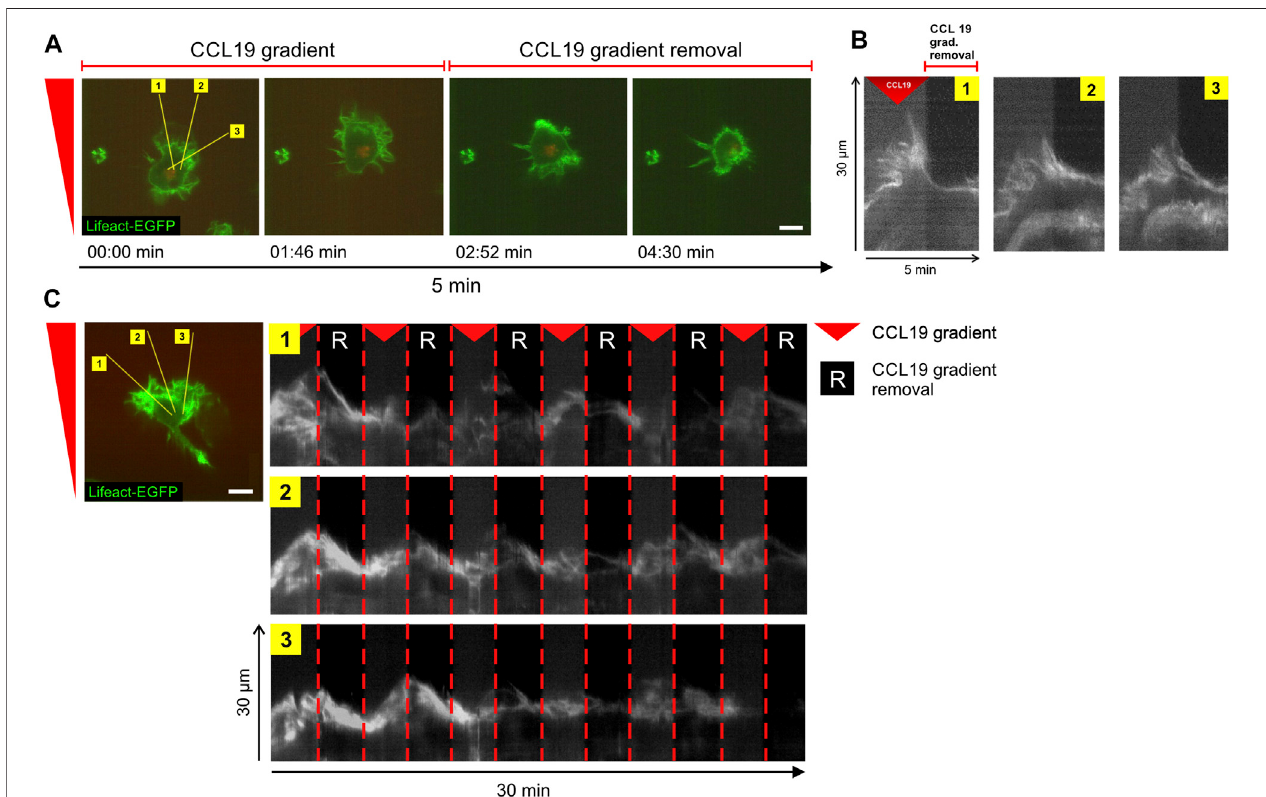
FIGURE5| Steady-statechemokine-gradientsareessentialtostabilizeleadingedgeprotrusionsinBM-DCs. (A,B) Time-lapseconfocalimagingsequenceofactin dynamicsandleading-edgepolarizationofasinglecellinastablesolubleCCL19gradient(for2.5 min)andfollowingCCL19gradientremoval(for2.5 min).Lifeact-EGFP expressing BM-DC was visualized over a period of 5 min at 2 s per frame. The yellow lines in (A) mark kymographs (time-space-plots) plotted in (B) . The kymographs displayactindynamicsoftheregionsovertime. (C) Time-lapseconfocalimagingsequenceofactindynamicsandleading-edgepolarizationofasinglecellexposed tosequentialremovalandre-applyofstablesolubleCCL19gradients.Lifeact-expressingBM-DCwasvisualizedoveraperiodof30 minat2 sperframe.Theyellowlines (left panel)markkymographs(time-space-plots) plottedontherightpanel.Green=Lifeact-EGFP.Redtrianglemarkpresence and “ R ” absenceofstablesolubleCCL19 gradients. Scale bars = 10 µm. Representative data from one of fi ve experiments. See also Supplementary Video S5 .